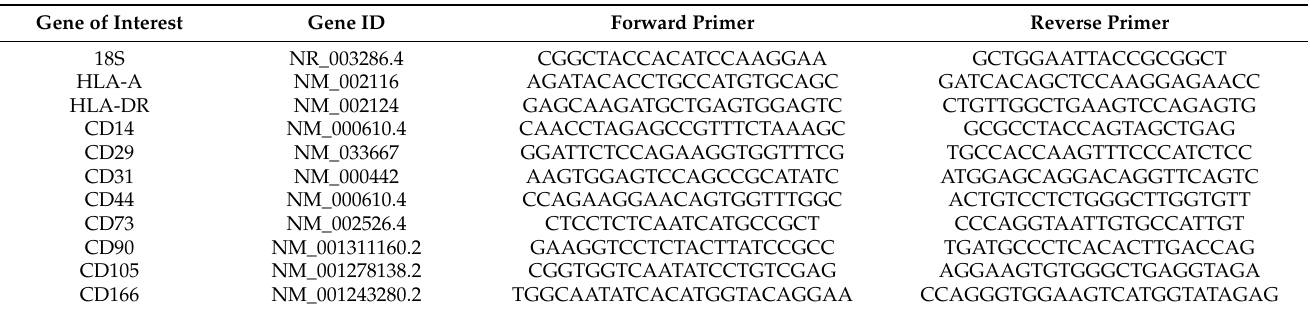
Table 1. List of the primers used for the real-time